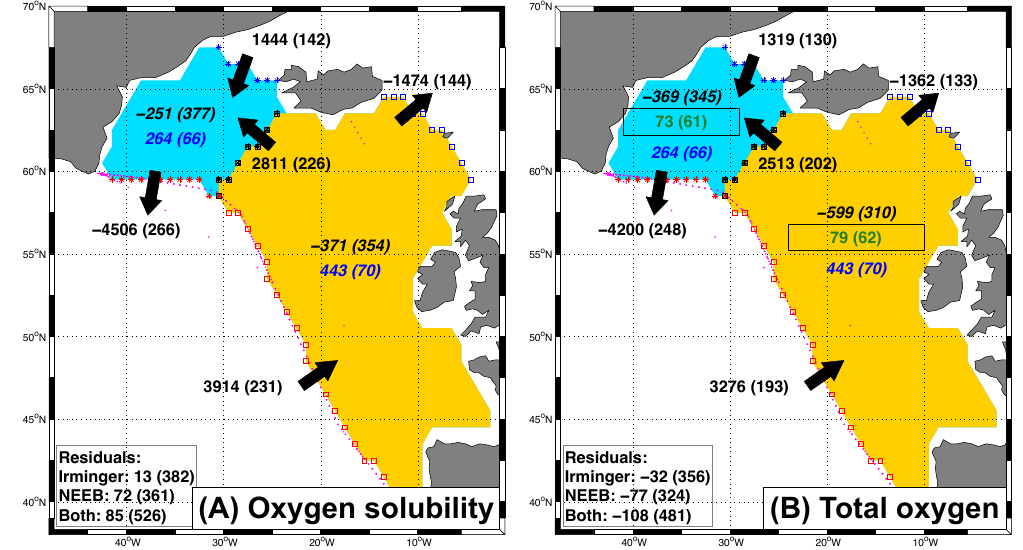
Fig. 3. (A) Oxygen solubility and (B) total oxygen budget terms in kmol s − 1 . Values are net for each box – i.e. negative value reducing concentration – except for the transport through RR, which is plotted for the Irminger box (sign needs to be changed for the NEEB box). Black arrows indicate the transport direction. In the center of each box, italic values are the transport divergence, blue values are the air–sea abiotic oxygen flux (positive, downward) and framed green values are the biological net source/sink term for total oxygen. In the lower left corner are indicated the box and domain residuals, i.e. the left-hand sides of Eqs. (4)–(5). Values within parenthesis are error